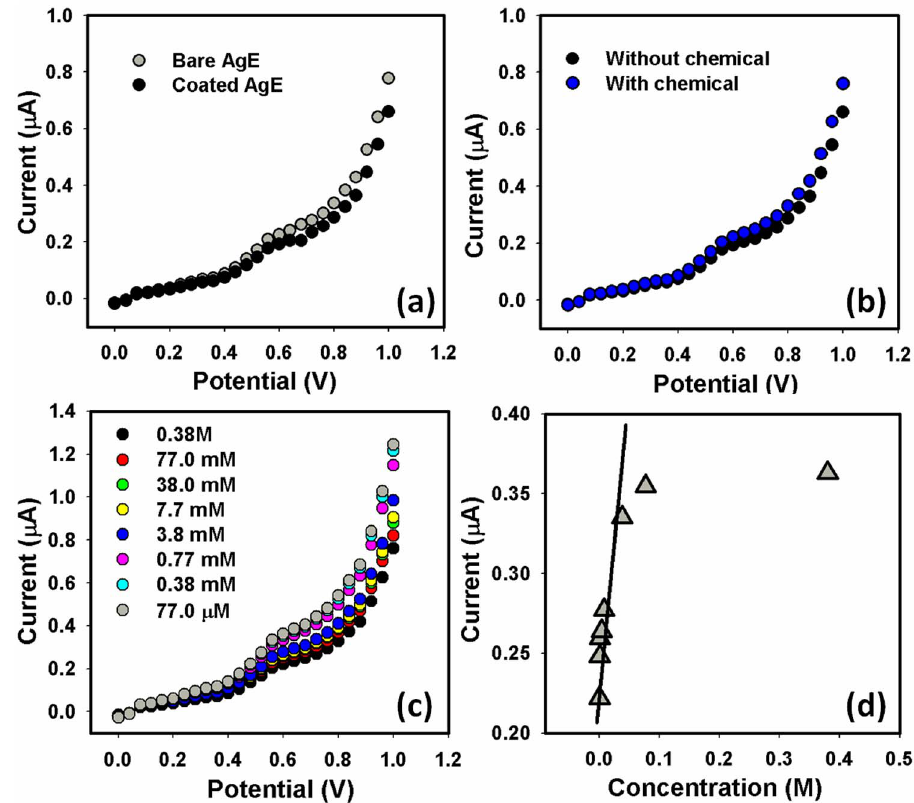
Figure 5. I–V characterization of composite nanoparticles (a) Comparison of with and without composite nanoparticles coating on AgE, (b) Comparison of with and without phthalimide, (c) effect of phthalimide concentration, and (d) calibration plot.